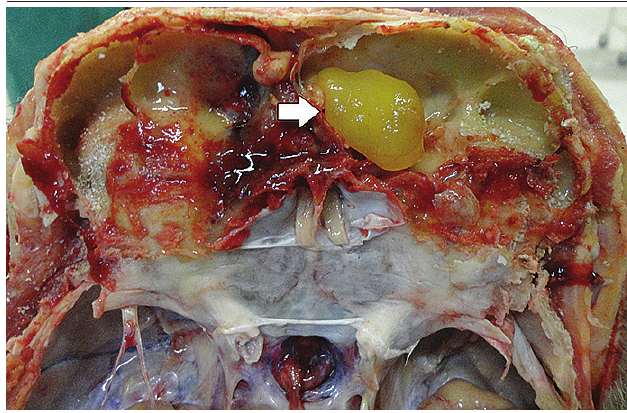
figurE 2 − Frontal and ethmoidal paranasal sinuses with yellowish polypoid projections (arrow)